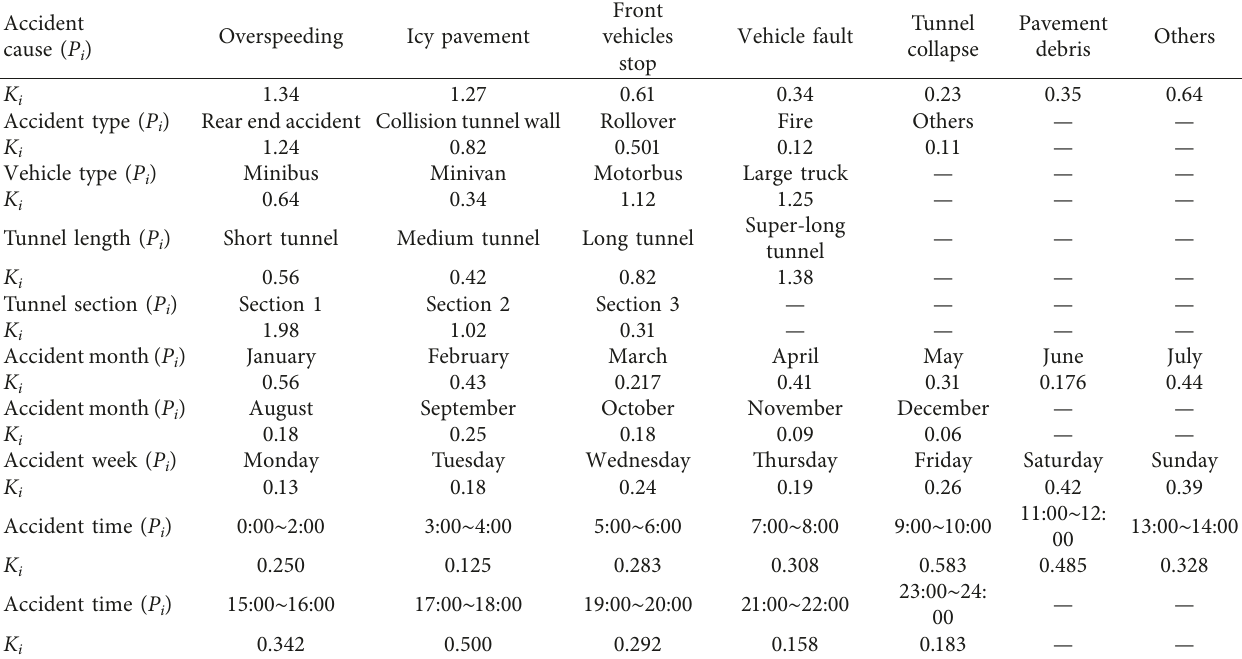
Table 3: Influence weight of objective factors on casualties.